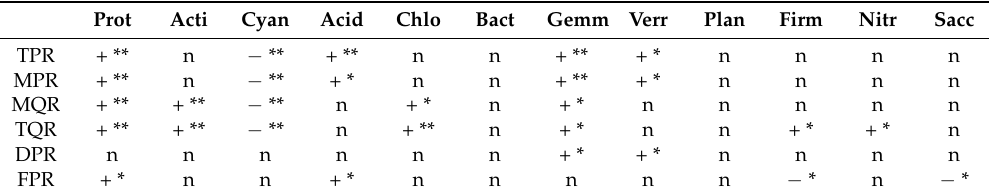
Table 1. Correlation coefficients between soil organic carbon accumulation and bacterial taxa abundance in each sample group. Bacterial taxa: Proteobacteria (Prot), Actinobacteria (Acti), Cyanobacteria (Cyan), Acidobacteria (Acid), Chloroflexi (Chlo), Bacteroidetes (Bact), Gemmatimonadetes (Gemm), Verrucomicrobia (Verr), Planctomycetes (Plan), Firmicutes (Firm), Nitrospirae (Nitr), and Saccharibacteria (Sacc).